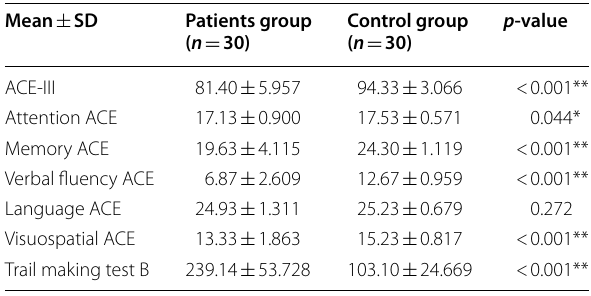
Table 3 Comparison between results of neurocognitive scales in both groups